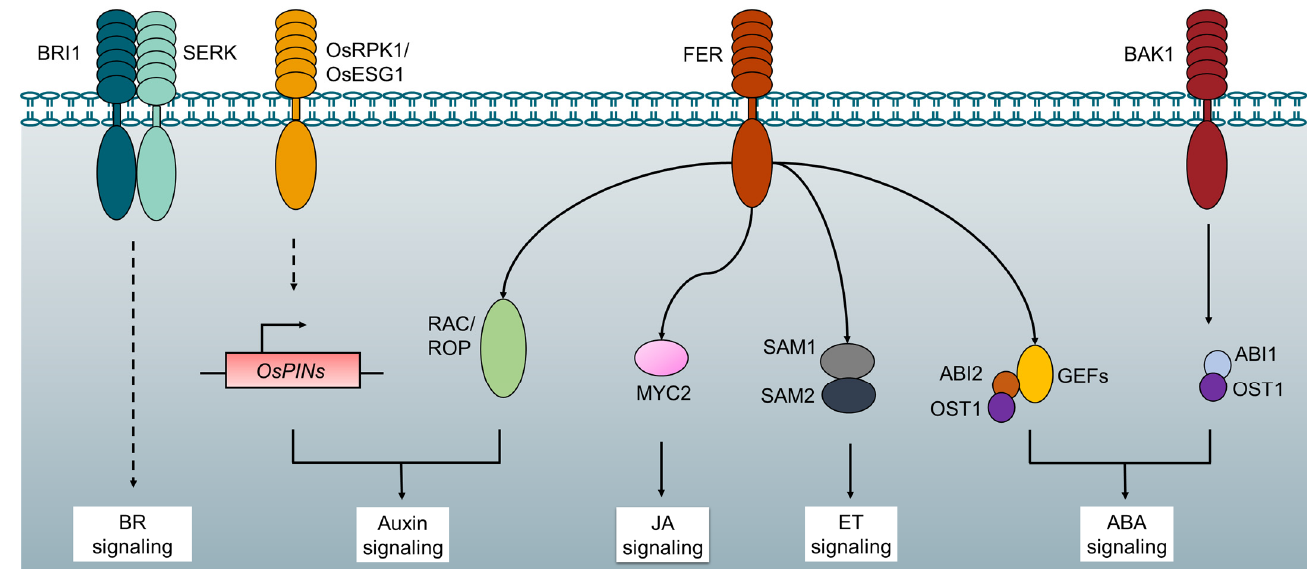
Figure 3. RLKs regulate phytohormone signaling. BRI1 recruits its co-receptor SERK3/BAK1 in the process of sensing BR signals. OsRPK1 and OsESG1 affect transport and distribution of auxin. FER interact with ROP/RAC, MYC2, SAM1/SAM2, GEFs/ABI2/OST1 to regulate auxin signaling, JA signaling, ET signaling and ABA signaling, respectively. ABI1 interacts with BAK1 to cause ABA-induced stomatal closure.